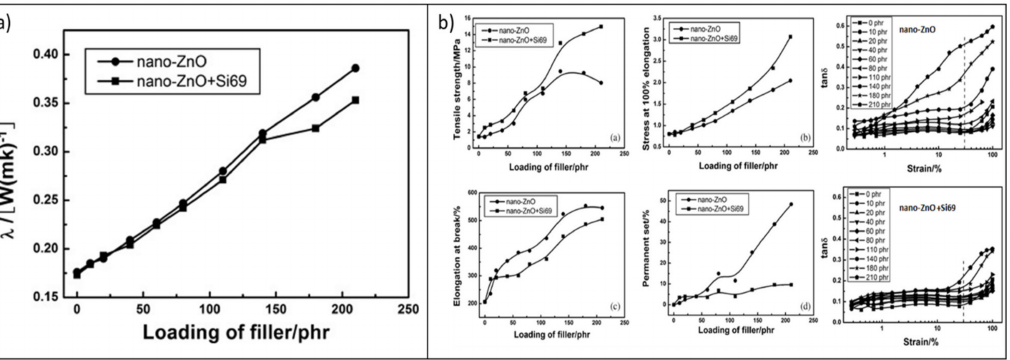
Figure 18. ( a ) Trend of the thermal conductivity of EPDM nanocomposites as a function of bare (nano-ZnO) and surface- functionalized ZnO (nano-ZnO+Si69) nanoparticles; ( b ) summary of the main static and dynamic mechanical properties of ZnO/EPDM rubber nanocomposites. Adapted from [195]. Copyright© 2021 Wiley Periodicals, Inc. All rights reserved.